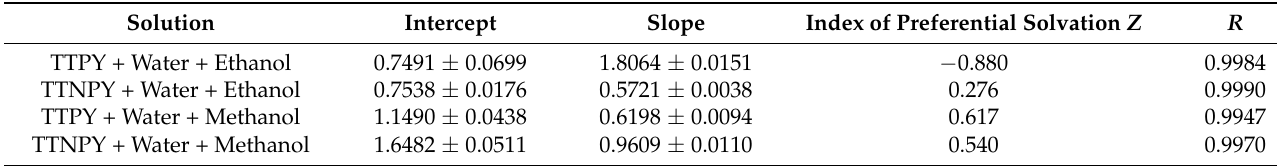
fits). In the case of the binary solvent mixture water + ethanol, Suppan’s model predicts = 0.79).